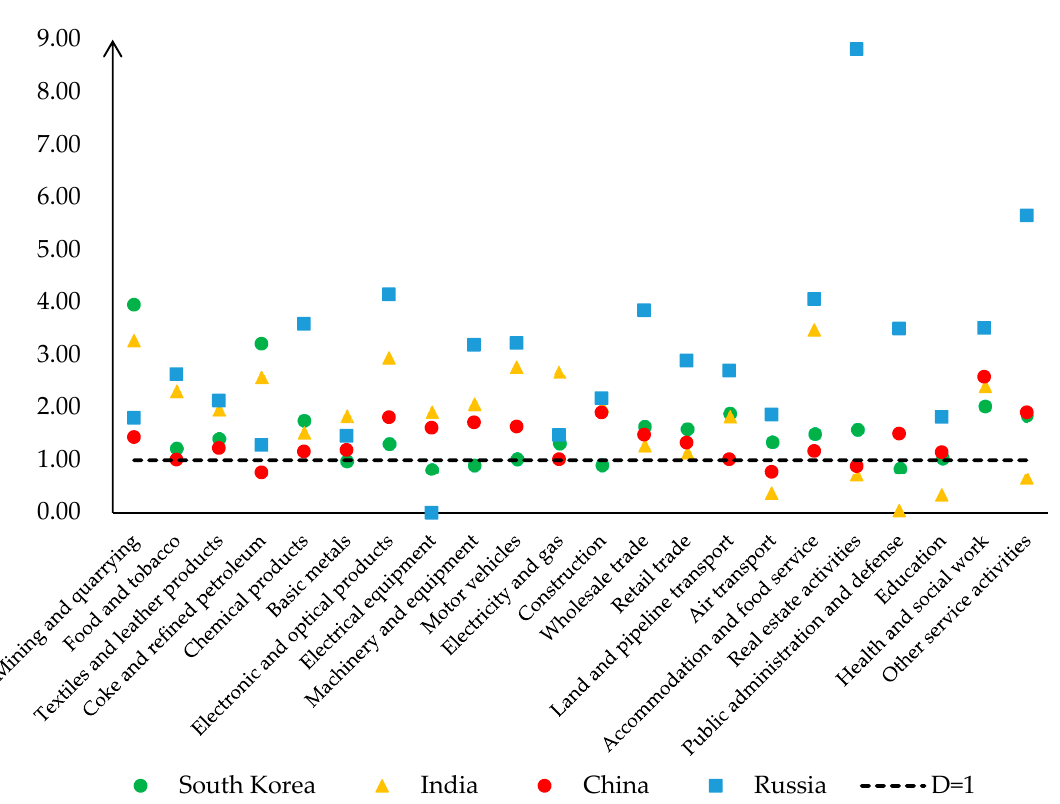
Figure 3. The ratio of the embodied energy intensity (EEI) of key sectors in high energy intensity countries to the average level of corresponding sectors in G20 countries in 2014.